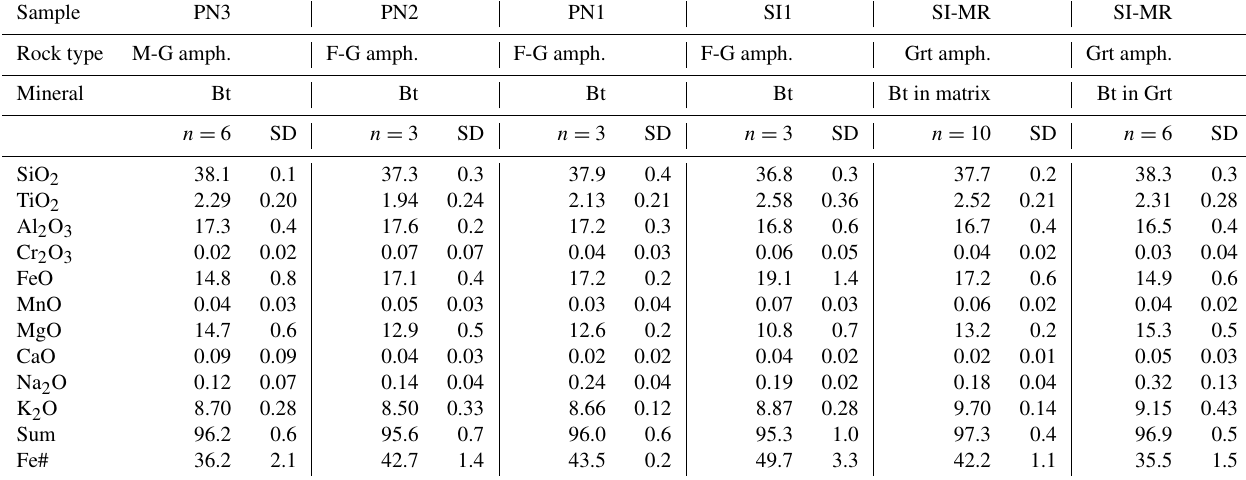
Table 5. Electron microprobe analysis of biotite (average values, wt%). Sample PN3 PN2 PN1 SI1 SI-MR SI-MR Rock type M-G amph. F-G amph. F-G amph. F-G amph. Grt amph. Grt